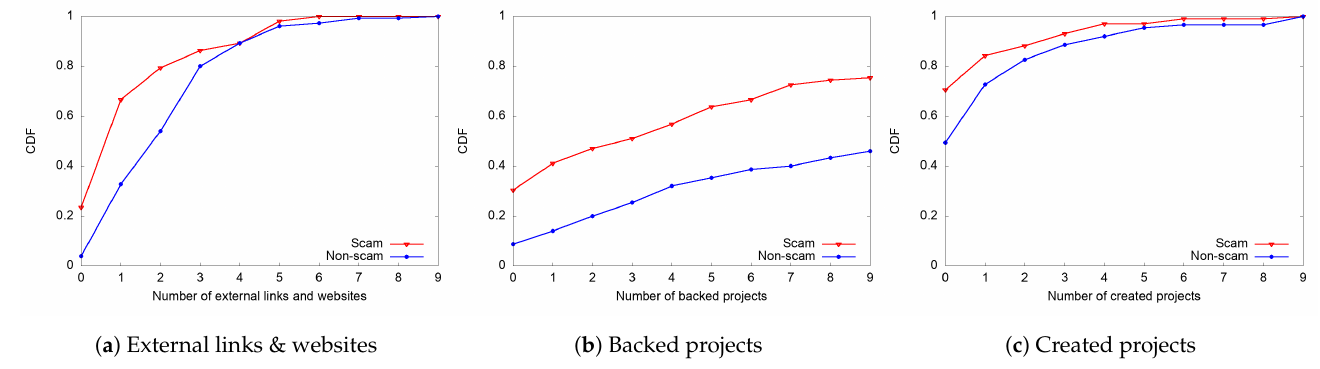
Figure 3. Cumulative distribution function(CDF) of key creator-related